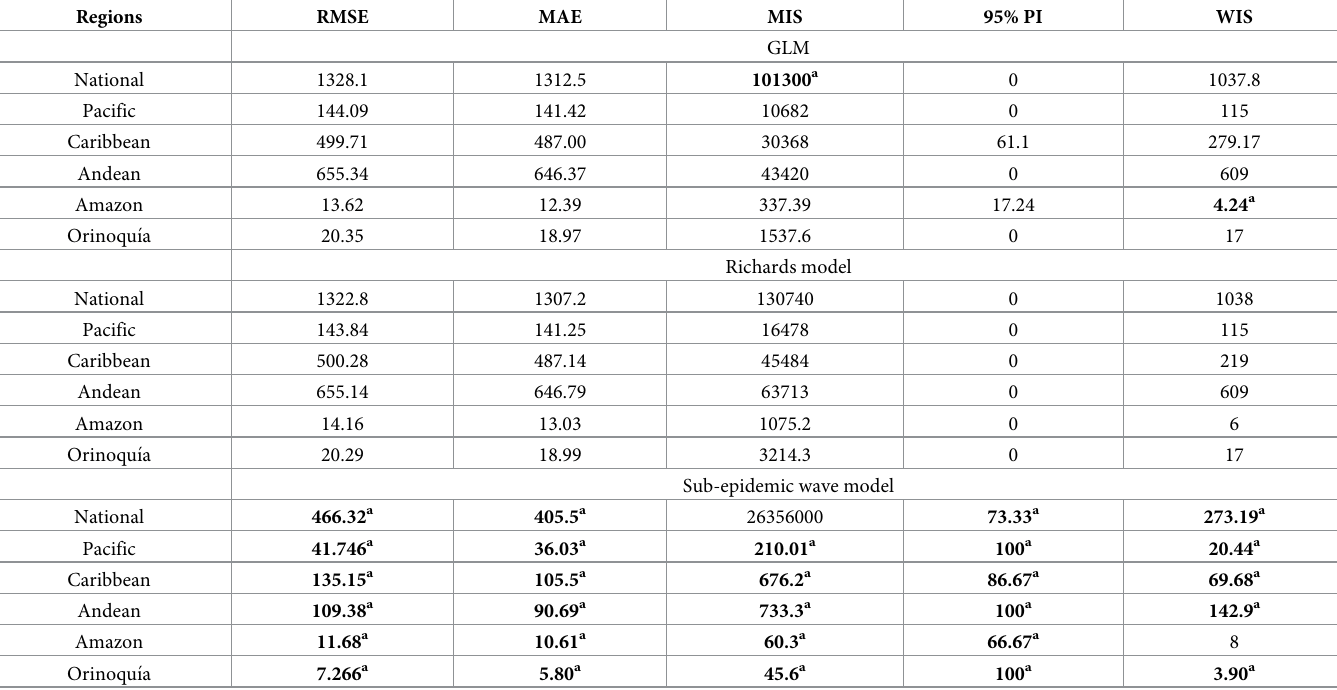
Table 3. Comparison of 30-day ahead forecasting performance (October 2, 2021 to October 31, 2021) by calibrating the GLM, Richards and the sub-epidemic model for 90 epidemic days (July 4, 2021 to October 1, 2021) at the national and regional level. Higher 95% PI coverage and lower RMSE, MAE, WIS and MIS repre- sent better performance. Best performing model is given in bold with the superscript